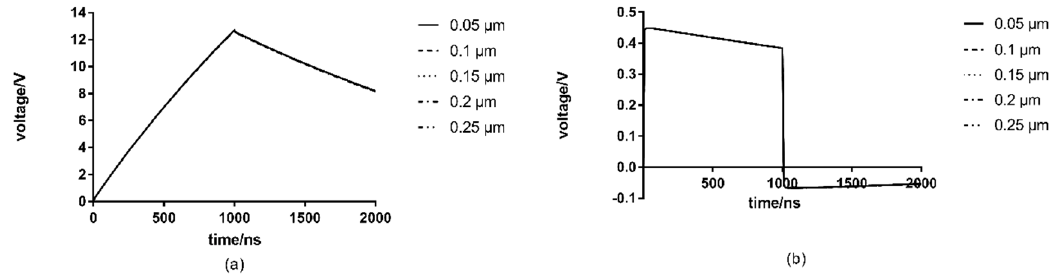
Figure 5. E ff ects of cell wall thickness on the transmembrane voltage: ( a ) cell membrane transmembrane Figure 5. Effects of cell wall thickness on the transmembrane voltage: ( a ) cell membrane voltage ( b ) nuclear membrane transmembrane transmembrane voltage ( b ) nuclear membrane transmembrane voltage.